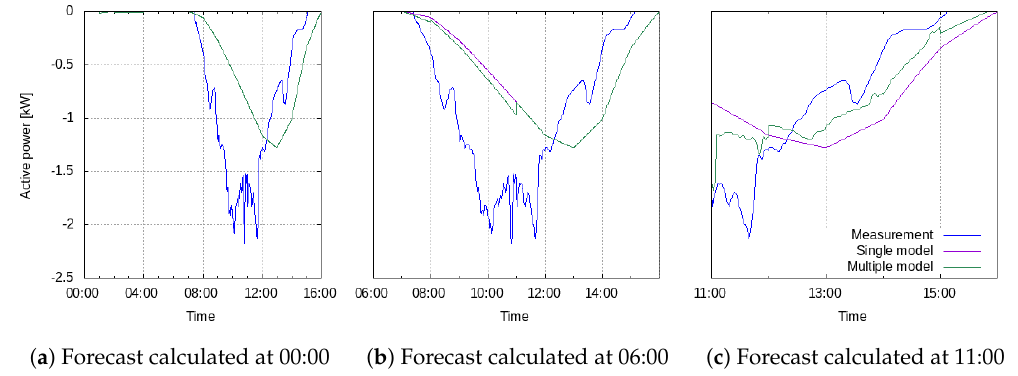
Figure 5. A forecast by multiple models (green) yields better forecasts for the production of a photovoltaic plant compared to a forecast by a single model only based on the weather forecast (purple) when compared to the measured data (date: 23 November